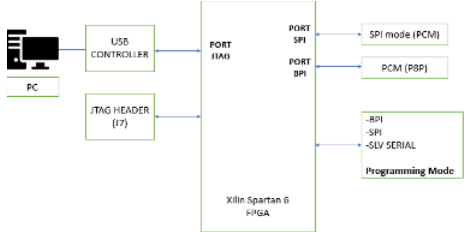
Fig. 4. Circuit of FPGA hardware connected with computer that uses AI technologies.